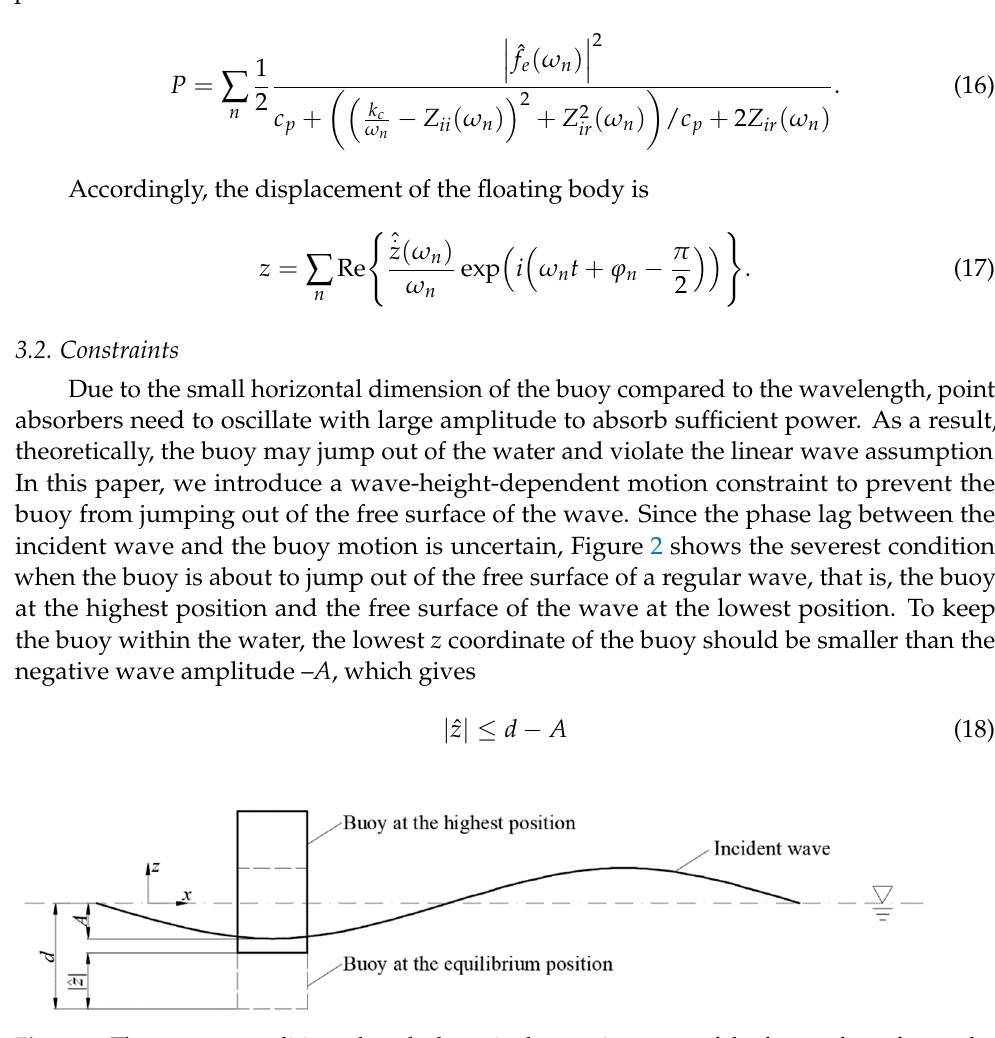
Figure 2. The severest condition when the buoy is about to jump out of the free surface of a regular wave.